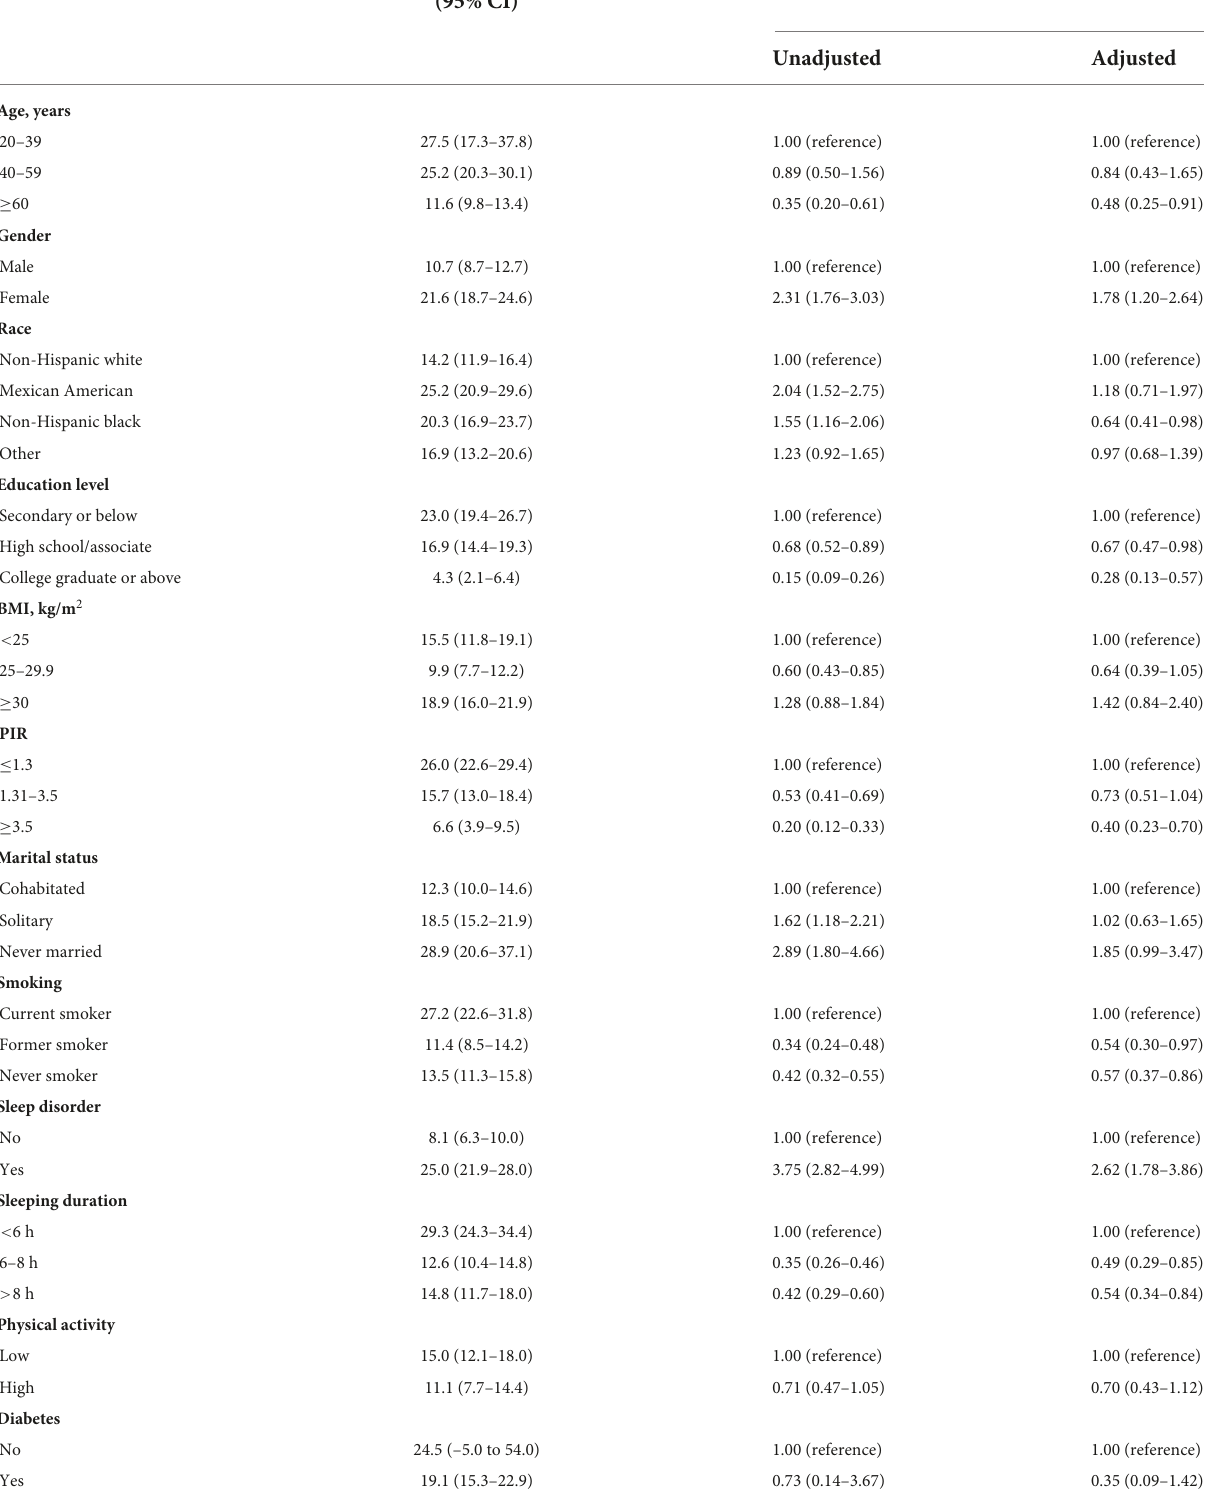
TABLE 2 Prevalence and odds ratios for depression by characteristics among adults with cardiovascular disease in the United States, 2009–March 2020.